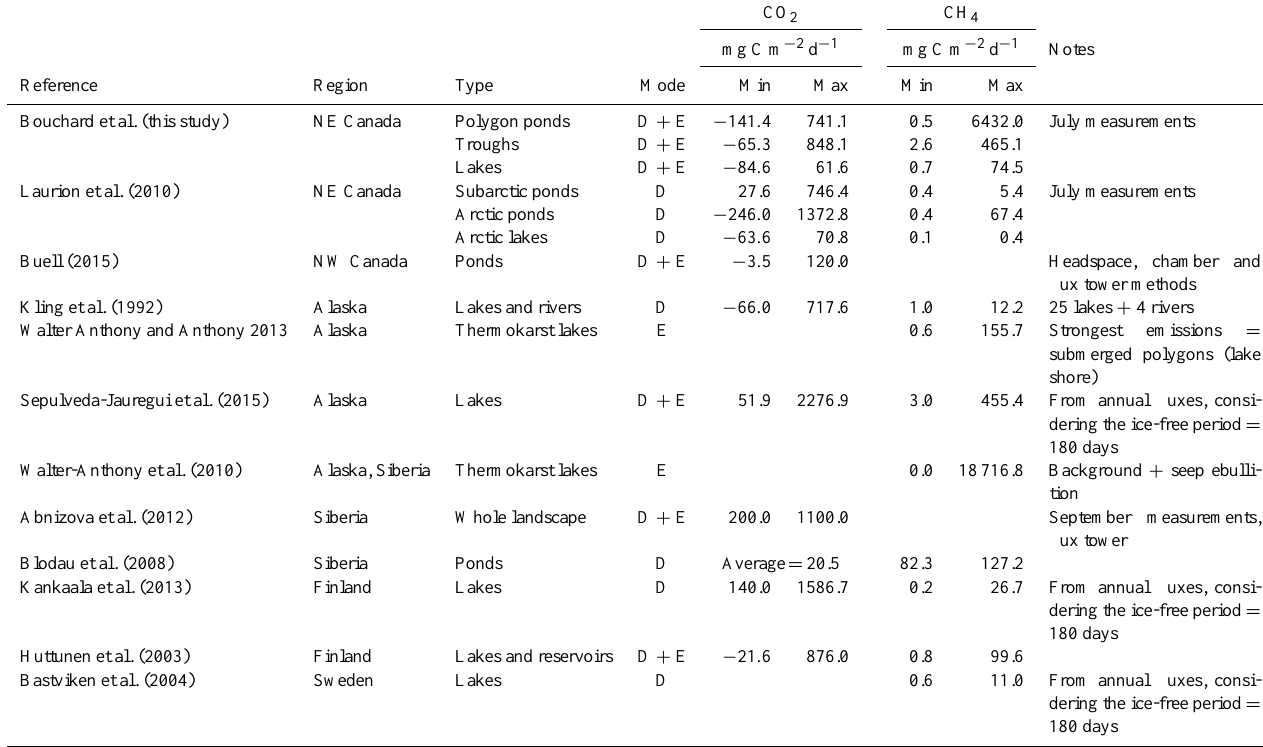
Table 4. Greenhouse gas fluxes of CO 2 and CH 4 from high-latitude sites across the circum-Arctic. D = diffusion; E =